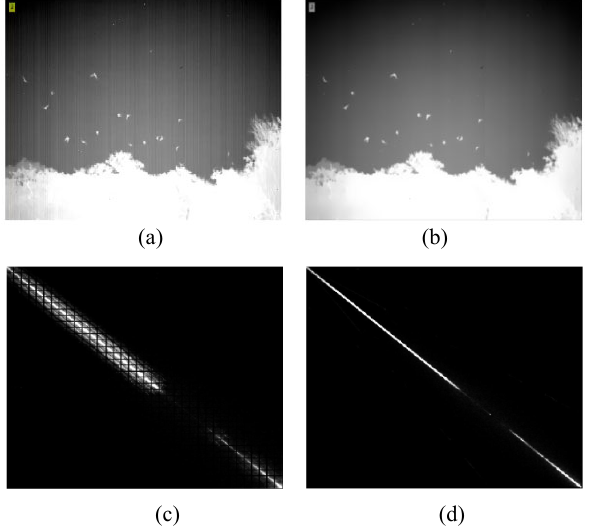
Table 3 Detection probability (%).